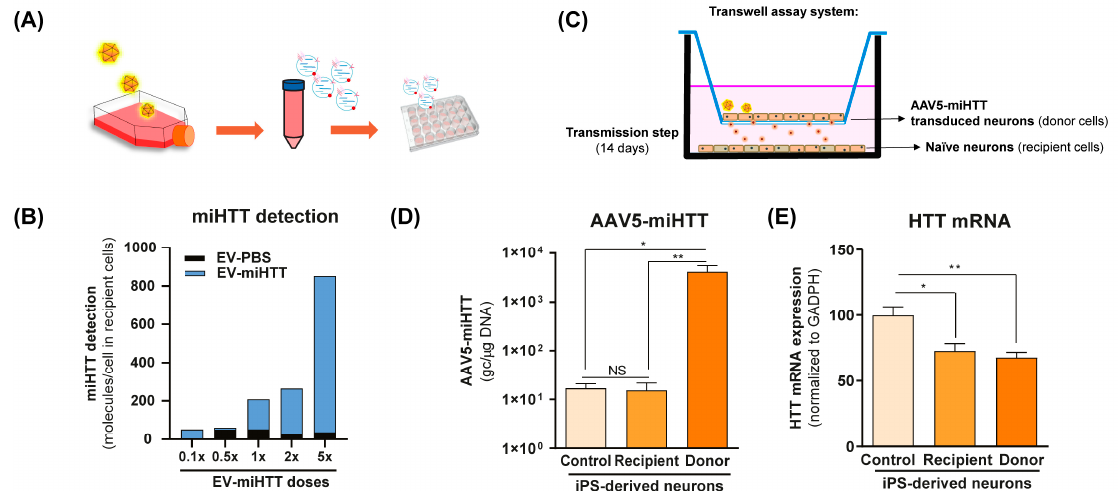
Figure 1. AAV5-miHTT transduction results in EV-associated secretion of miHTT molecules and HTT mRNA lowering in naïve HD patient iPSC-derived neurons. ( A ) Schematic depicting the transduction of HD patient-derived iPSC neurons with AAV5-miHTT. EVs secreted from these cells were isolated at days 5 and 12 post-transduction and were subsequently added to naïve HD patient iPSC-derived neurons. ( B ) Pooled and serially diluted EVs (obtained from transduced HD patient iPSC-derived neurons) were added to naïve HD patient iPSC-derived neurons, and miHTT detection was performed by RT-qPCR. N = 1 replicates per experimental condition. ( C ) Schematic depicting a contactless transwell assay using naïve HD patient iPSC-derived neurons as recipient cells and AAV5-miHTT transduced HD patient iPSC-derived neurons. Negative control preparations were naïve HD patient iPSC-derived neurons. Cells were cultured for 2 weeks and subsequently assessed for ( D ) AAV5-miHTT genome copy number. N = 6 replicates per experimental condition, and ( E ) HTT mRNA knockdown using RT-qPCR. N = 6 replicates per experimental condition. (* p < 0.02, ** p < 0.002, NS: non